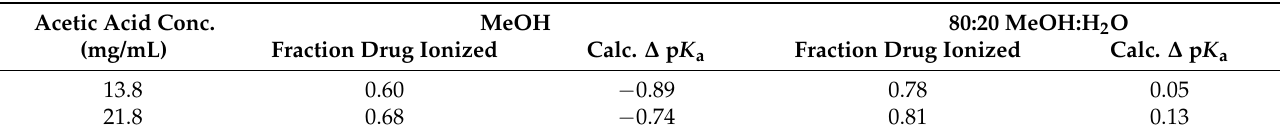
Table 2. Fraction ionized and calculated ∆ p K a for two acetic acid concentrations in methanol